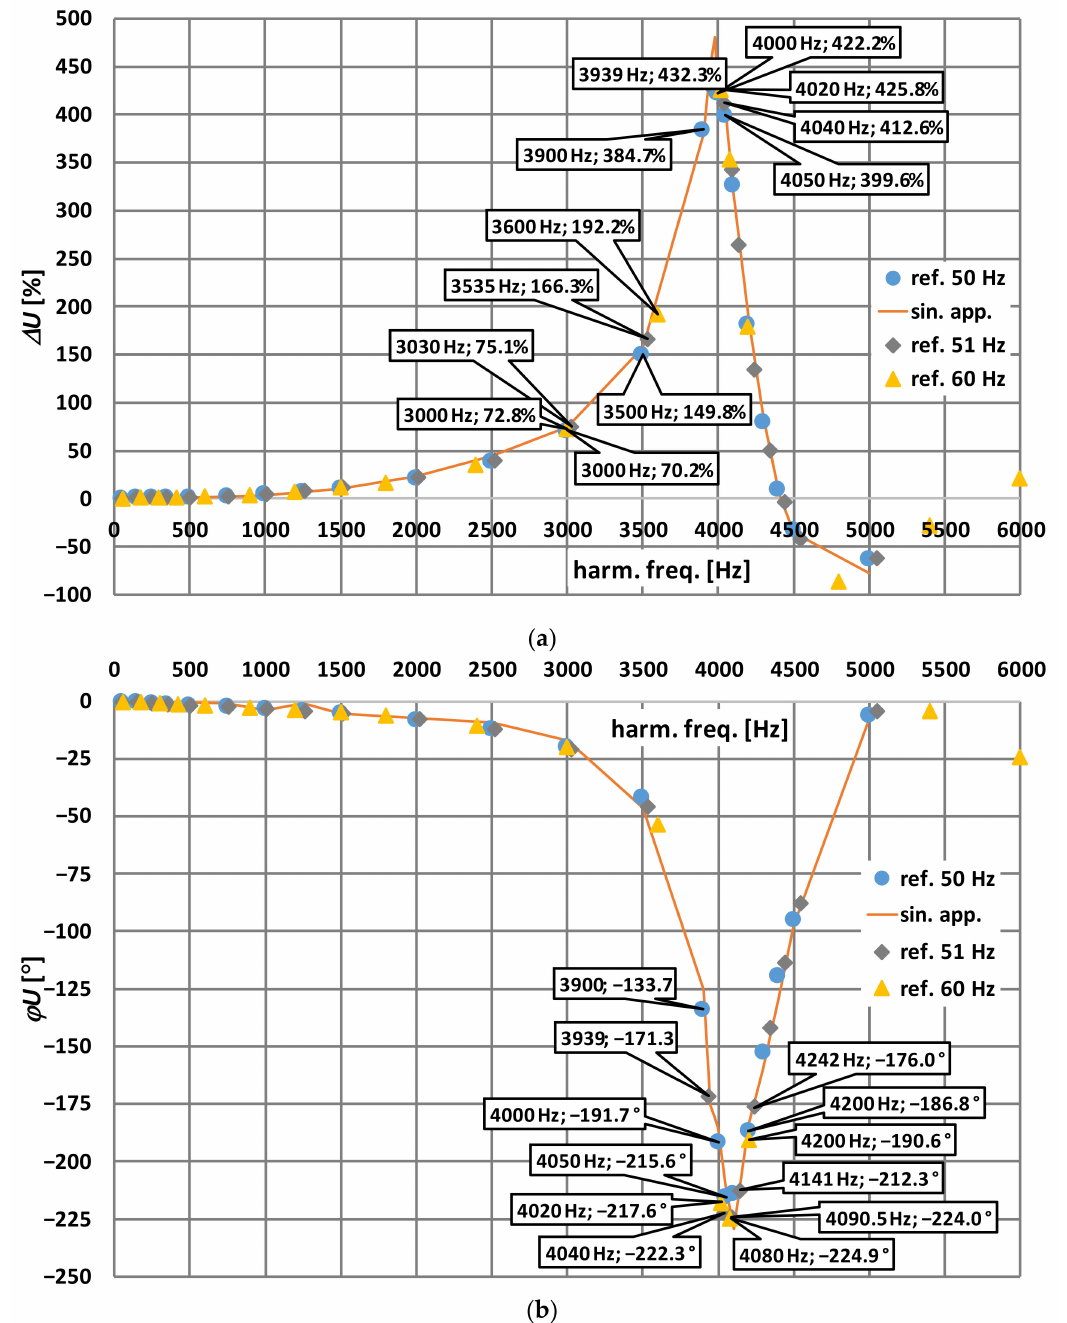
√ 3) kV VT when its secondary winding is loaded with